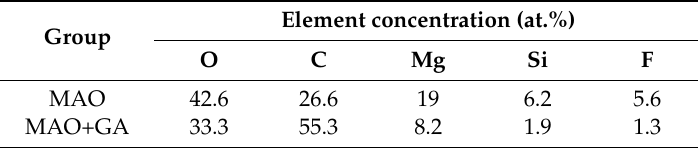
Table 1. XPS results of elemental